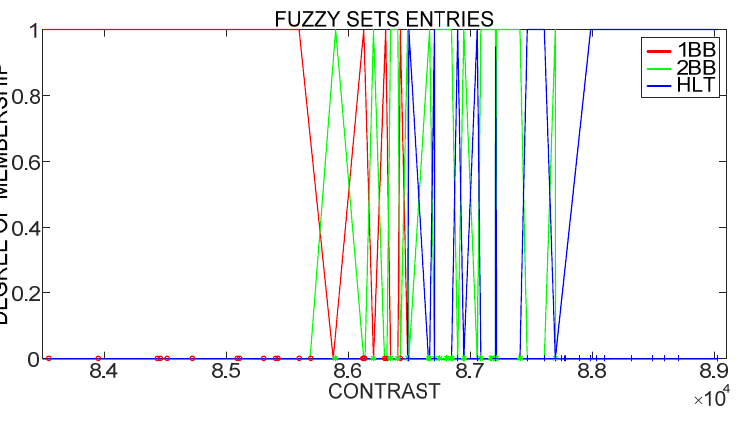
Figure 6. PDFs from contrast values computed through Unser definition for a healthy motor (HLT), a motor with one broken rotor bar (1BRB) and a motor with two broken rotor bars (2BRB).